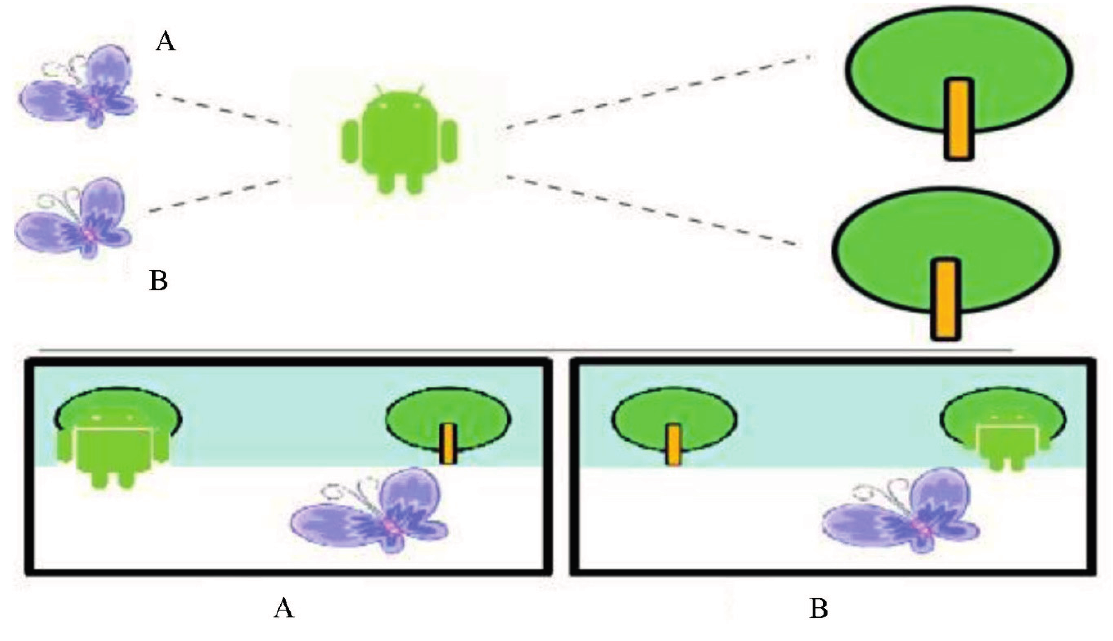
Figure 2. Motion